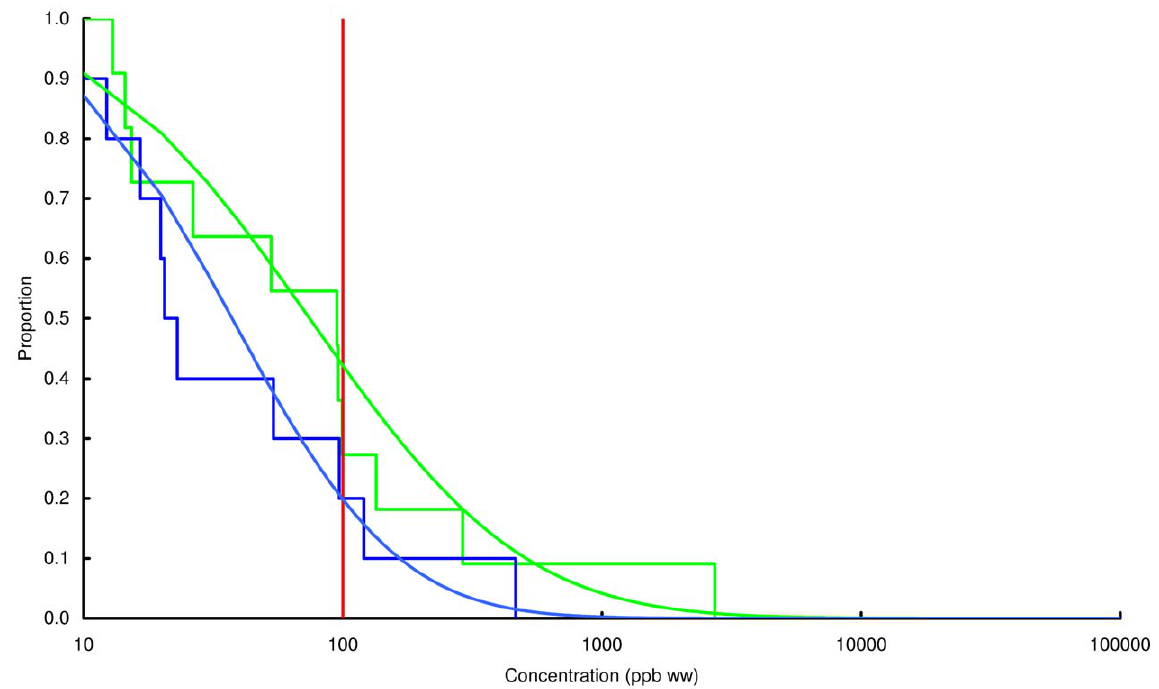
Figure 6. Exceedance distribution of lead concentrations in woodpigeon. Observed (stepped line) and fitted (curve) exceedance distribution of lead concentrations (ppb wet weight) in woodpigeon cooked using acidic (green) and non-acidic (blue) methods. The curves represent lognormal distributions fitted to all the data, including those below the limit of quantification, by a maximum-likelihood method involving left- censoring at the LOD/LOQ. The red vertical line shows the statutory maximum residue level (MRL) for poultry and other non-game meat.